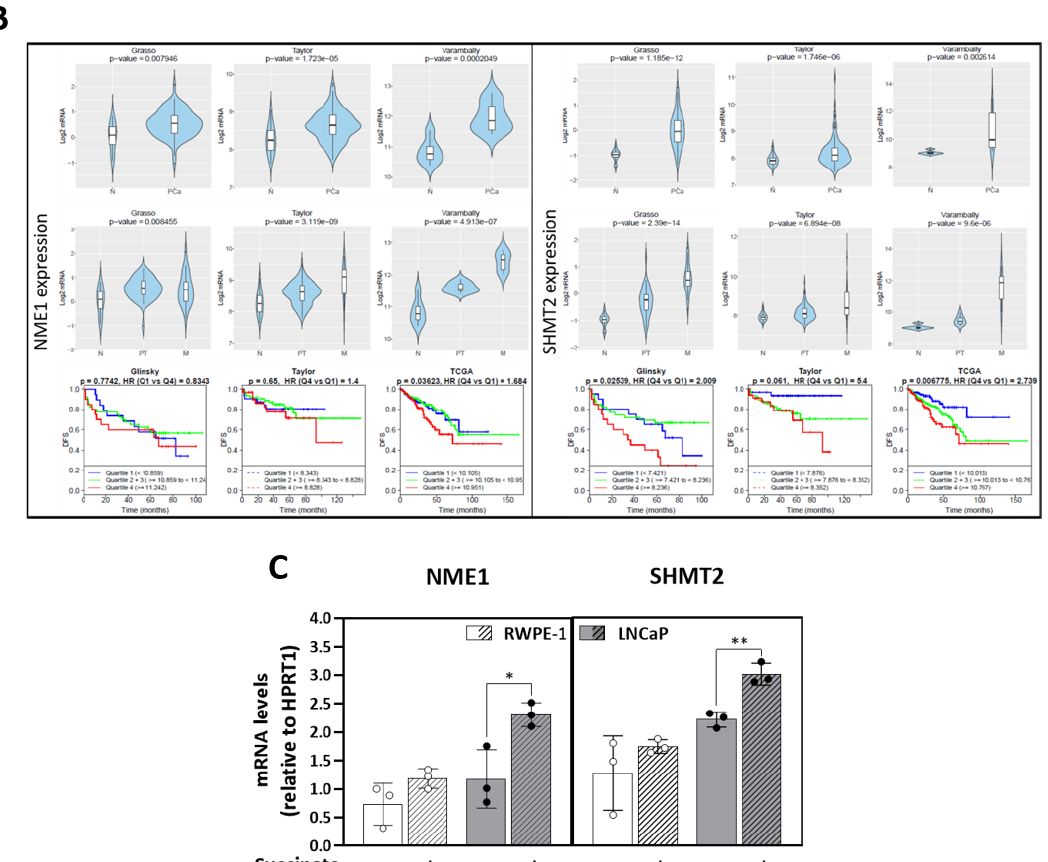
Figure 6. Expression of enzymes linked to metabolites stimulated by succinate in transcriptomic cohorts of prostate cancer patients. ( A ) Boxplots representing Fragments Per Kilobase Million (FPKM) values for expression of significantly upregulated genes in prostate cancer (PCa) (pink) vs. the paired benign (blue) biopsies ( N = 16, [25]). Data are presented as boxplots with median, 25 th –75 th percent percentile (box). Multiple t -test followed by Benjamini–Hochberg correction for multiple testing. ( B ) Significantly increased mRNAs were analyzed using Cancer Tool free software [31] in different prostate cancer transcriptome datasets. The violin plots show the expression of NME1 and SHMT2 comparing normal tissue (N) and prostate cancer (PCa, upper panel), and metastasis when given (primary tumor, PT; metastasis M, middle panel). The Y -axis represents log2-normalized gene expression. Statistical significance between N and PCa was tested using t-test and between N, PT and M using Anova. For disease-free survival (DFS) analysis, Kaplan-Meier curves were divided into 4 quartiles according to gene expression: Q1 (Blue), Q2 + Q3 (Green), Q4 (Red) (bottom panel). Each curve represents the percentage of the population that exhibits recurrence of the disease in function of time. A Mantel-Cox test was performed to compare the differences between curves, while a Cox proportional hazards regression model was performed to calculate the Hazard Ratios (HR). Datasets: Glinsky et al. [33] ( N = 79); Grasso et al. [34] ( N = 88); Taylor et al. [35] ( N = 179); Varambally et al. [36] ( N = 19); TCGA-PRAD ( N = 496). ( C ) NME1 and SHMT2 mRNA expression with or without succinate (5 mM) for 48 h in RWPE-1 and LNCaP cells. mRNA levels are expressed normalized by the endogenous control HPRT1 ( N = 3; n = 2). Median and IQR. Two-tailed unpaired t -tests between control ( − ) and succinate (+). * p = 0.05, ** p <